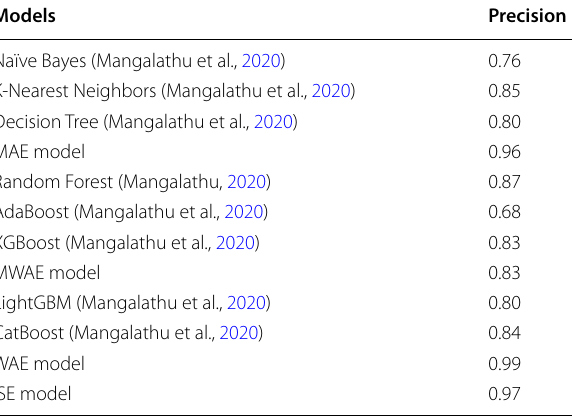
Table 7 Weighted-average precision of various methods.